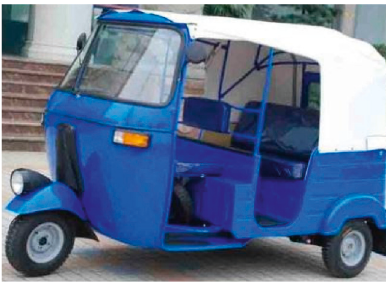
Figure 1: Three-wheeler structure.